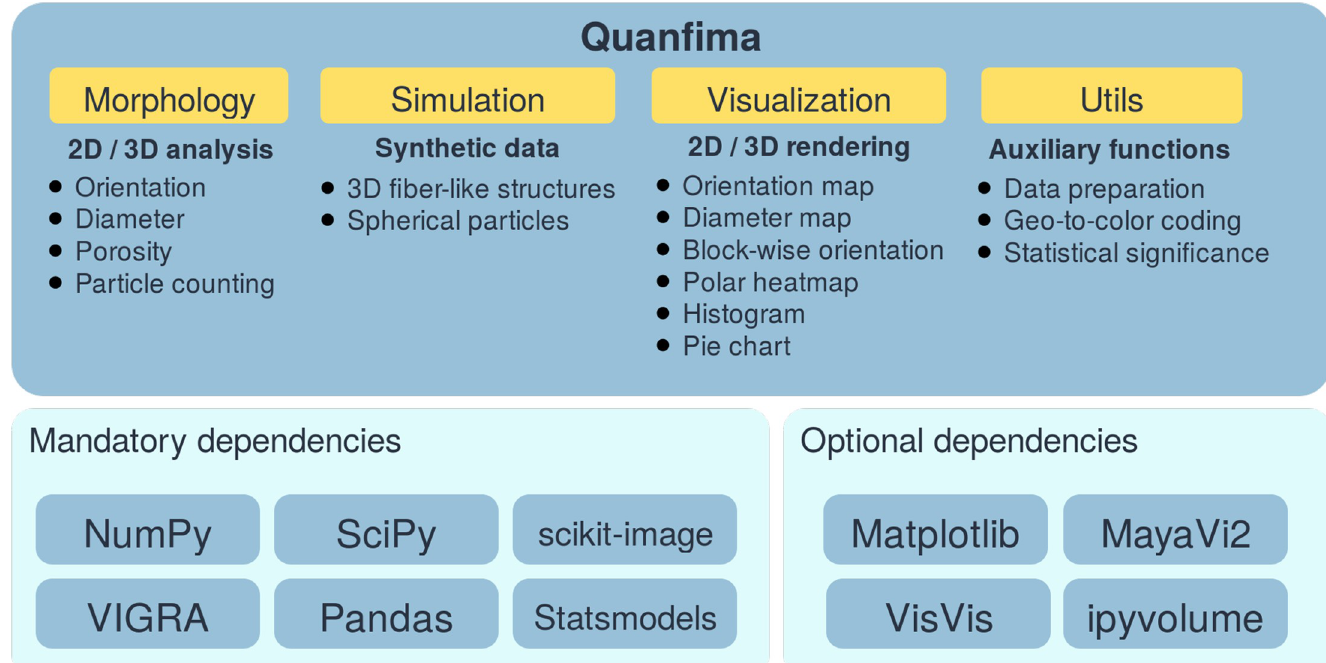
Fig 2. The general architecture of the quanfima package. Mandatory packages are included in a repository and serve as a base for quanfima. Optional packages are only necessary for the visualization module.